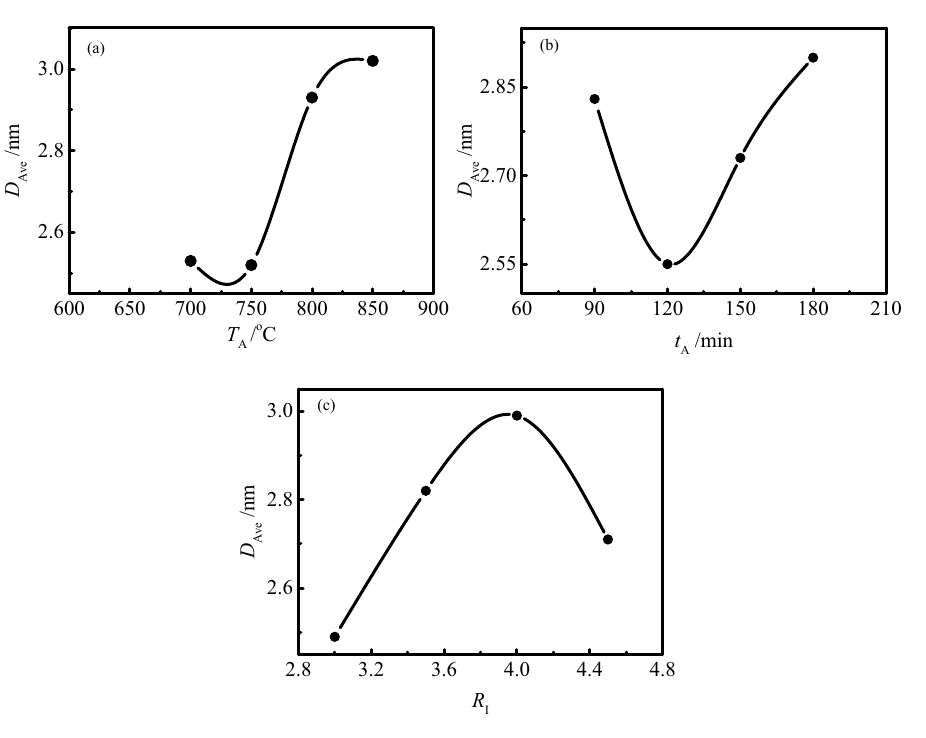
Figure 3. Effects of experimental factors on the average pore diameter of